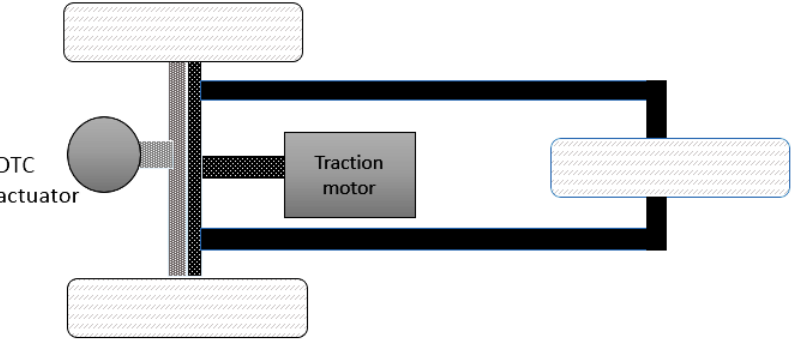
Figure 4. Schematics of the vehicle in this study and DTC actuator layout.